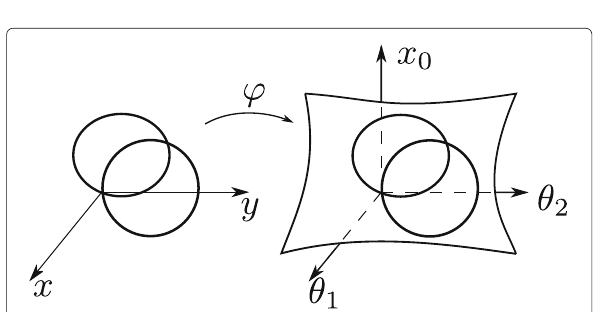
Fig. 16 Models of order − 1 (left) and model of order 0